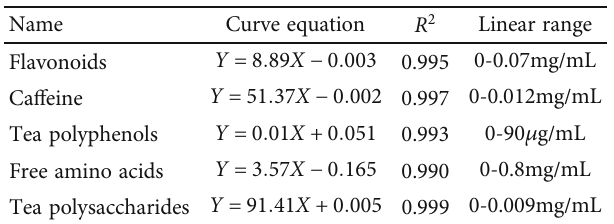
Figure 2: Technical route for functional analysis of tea leaves. Table 1: Standard curve equations.